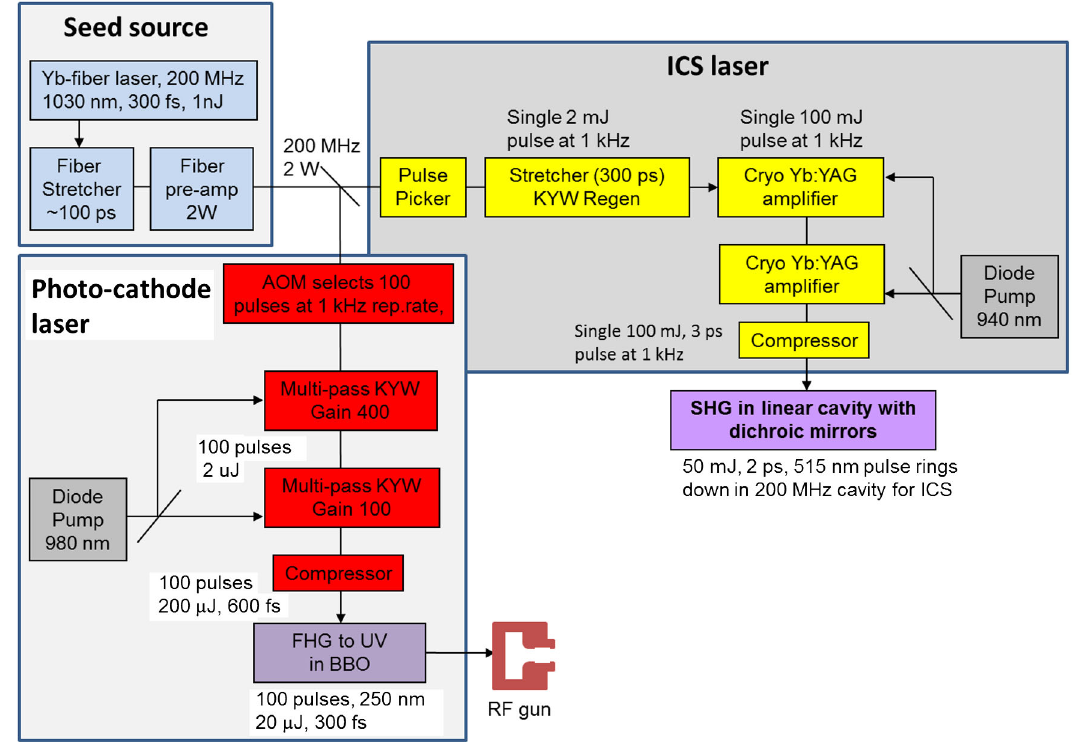
FIG. 13. Block diagram of the laser systems showing the common oscillator feeding into the amplifiers for the photocathode laser and ICS laser. The Yb ∶ KYW photocathode laser requires a 100 pulse train at 1 kHz repetition rate for an average output power of 20 W in the IR. The ICS laser is a cryocooled Yb ∶ YAG amplifier that produces a single 100 mJ IR pulse at 1 kHz. The IR pulse is coupled into a linear ringdown cavity where it is trapped using second harmonic generation and dichroic mirrors [20]. The 515 nm light then collides with electron bunches that arrive in a train synchronized to the cavity round-trip